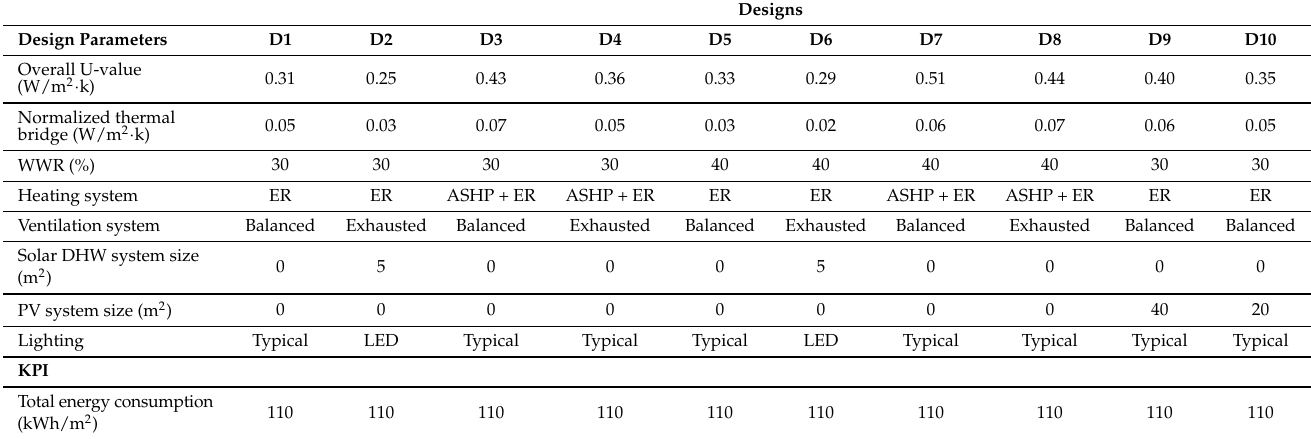
Table 2. Details of the ten competitive designs considered in the case study